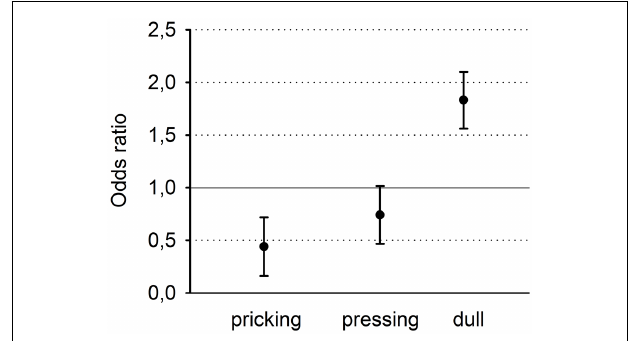
FIGURE 4 | Odds ratios and 95% confidence intervals of the three descriptors, sorted from left to right for increasing selectivity for second pain and decreasing selectivity for first pain